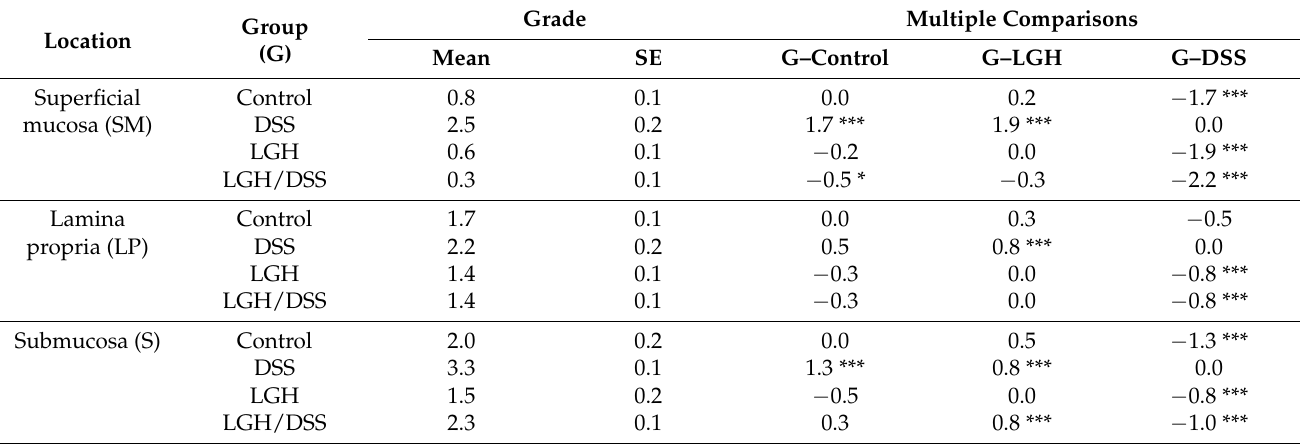
Table 3. Multiple comparisons of IL-6 expression in colonic mucosa and submucosa.